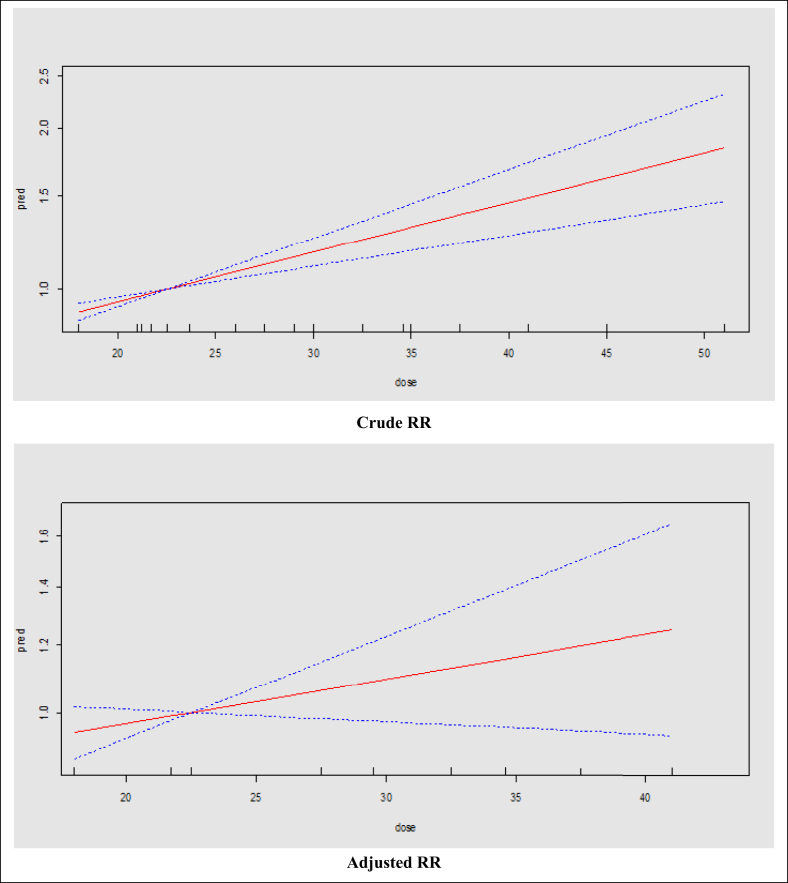
The dose-response relationship of BMI (kg/m2) and risk of BF cessation based on the linear model and crude and adjusted RR; the solid line represents the fitted linear trend and dash line represents the 95% confidence interval.